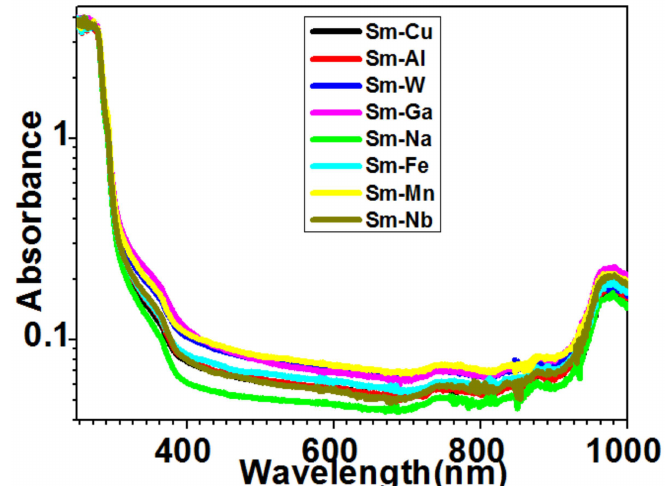
Figure 7. Optical absorption of Sm–Me (Me = Fe, Ga, Mn, Na, Nb, W, Cu, and Al)